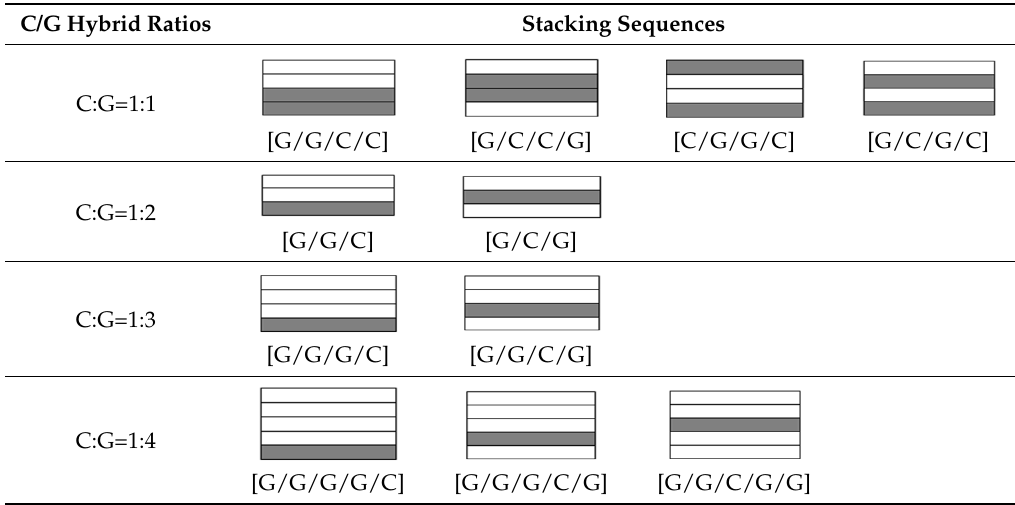
Table 3. Stacking configurations of interlayer hybrid structures.